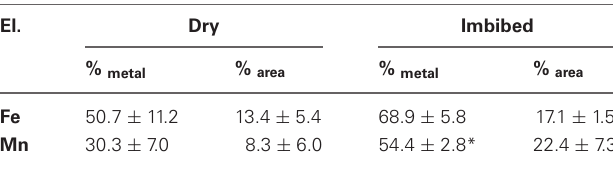
Table 3 | Fractions of Fe and Mn in Arabidopsis thaliana dry and imbibed